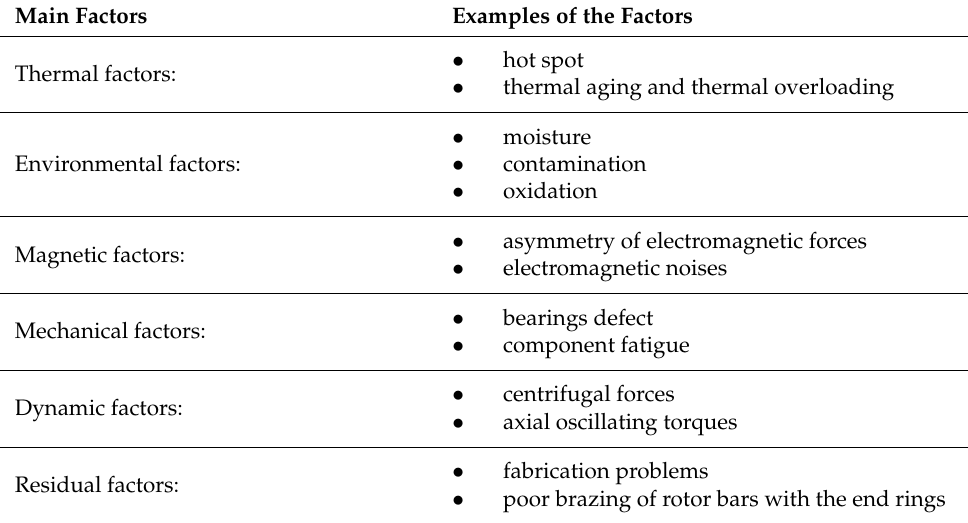
Table 1. The factors that can lead to rotor bar and end-ring